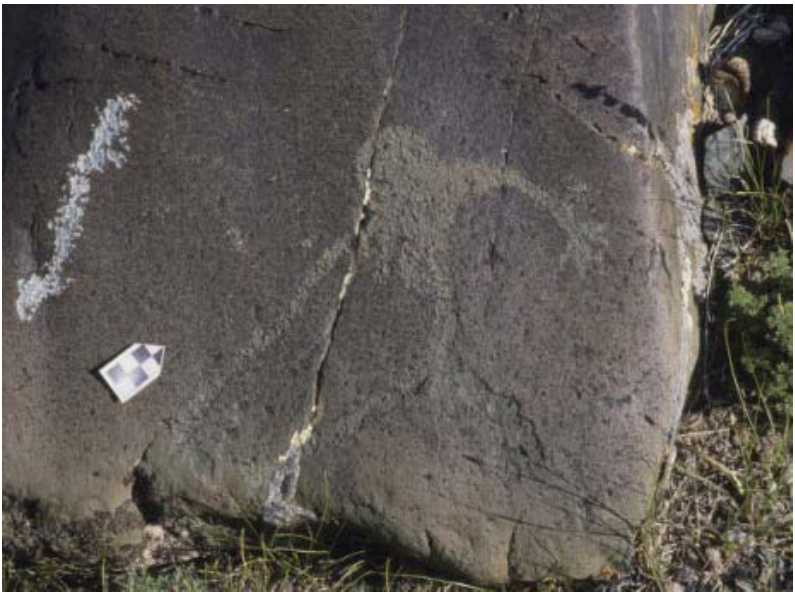
Figure 15. Mammoth (?) with contoured body and silhouetted head. Paleolithic period. Tsagaan Salaa IV.